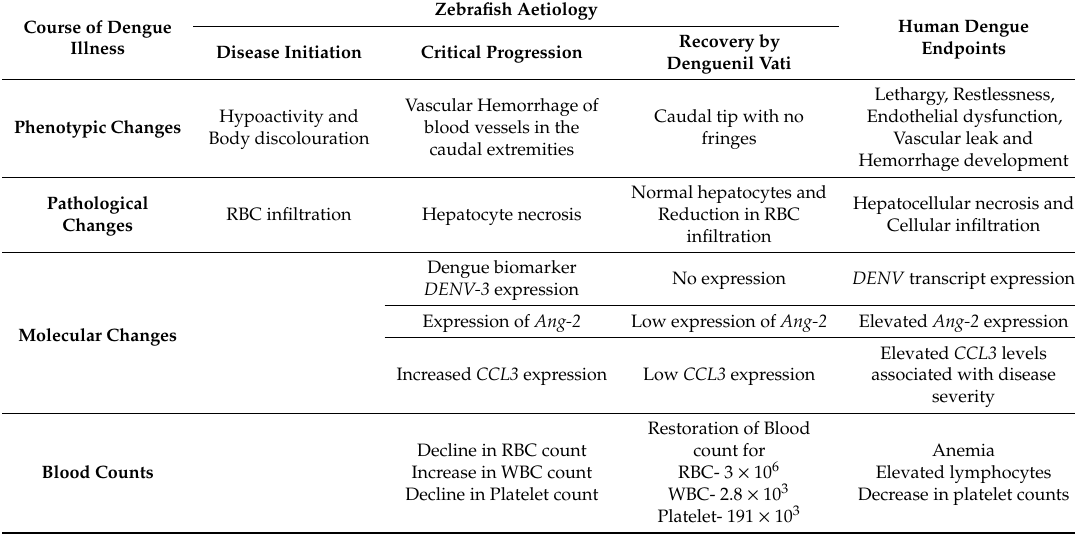
Table 1. The course of dengue infection and pathological changes. Various pathological features of dengue infection in zebrafish, its comparison with human dengue clinical signs, and subsequent therapeutic modulation by Denguenil